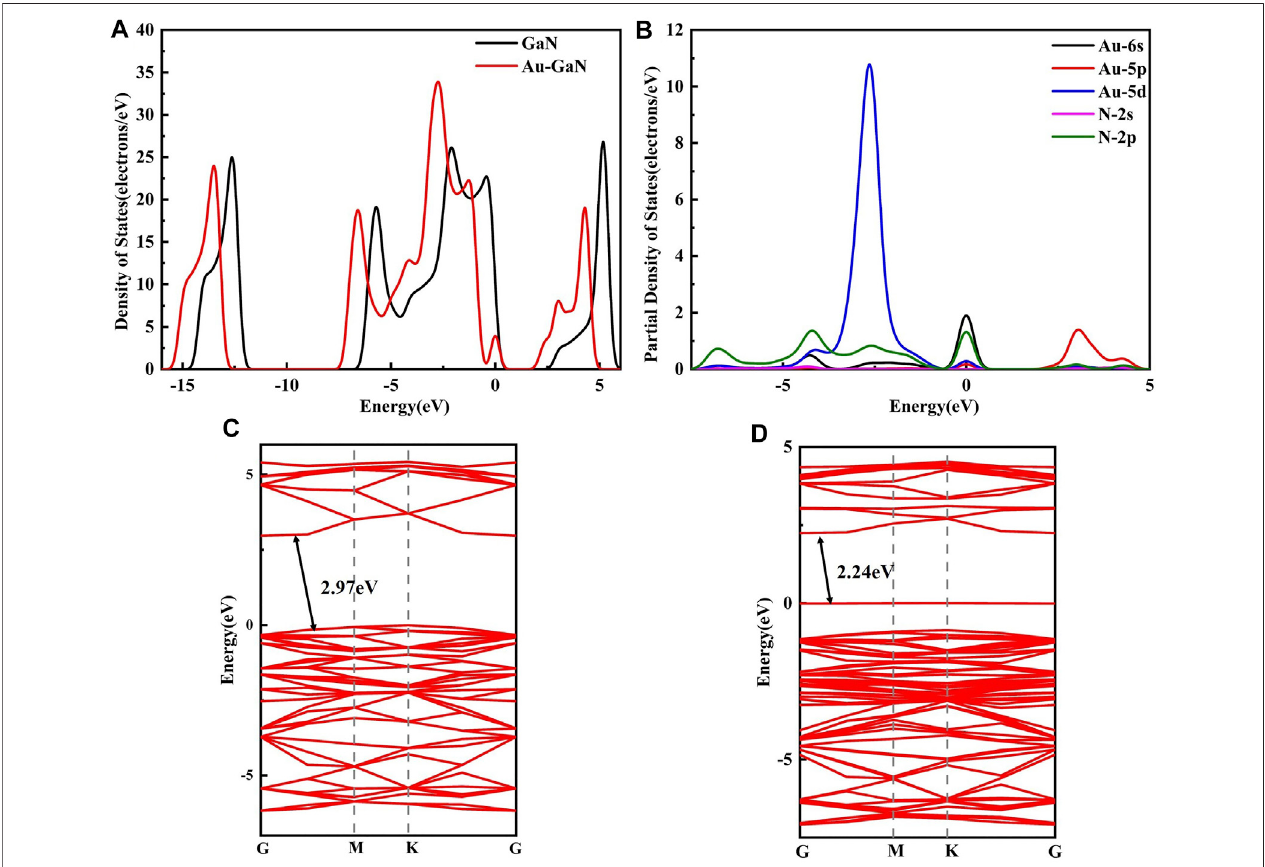
FIGURE 4 | (A) DOS of GaN and Au – GaN monolayer, (B) PDOS of Au-GaN monolayer, (C) band structure of GaN, and (D) band structure of Au – GaN.